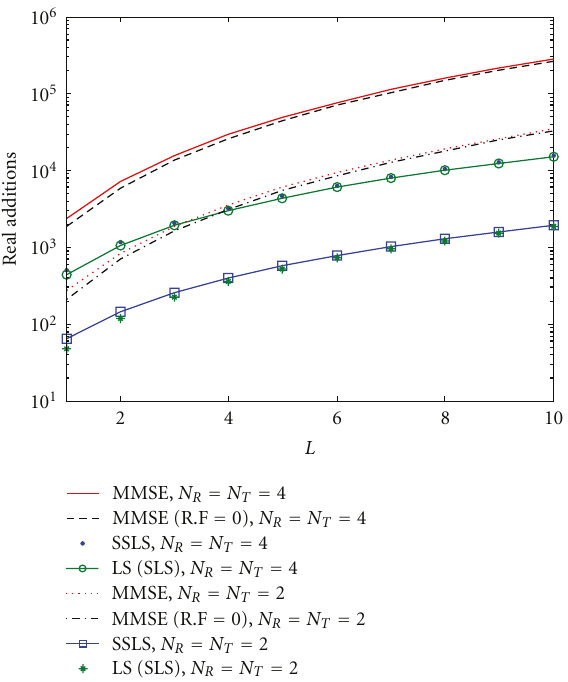
Figure 5: Computational complexity of the LS-based and MMSE channel estimators (Real additions for N T = N R = 2 and N T = N R =